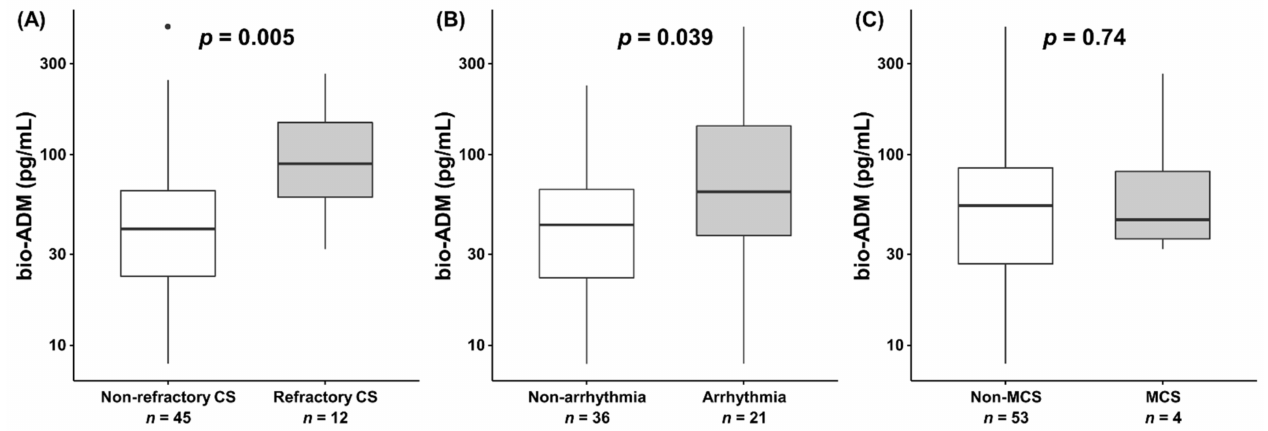
Figure 3. The value of bio-ADM at inclusion (boxplots) in ( A ) patients with or without refractory cardiogenic shock, ( B ) patients with or without arrhythmias (i.e., comprised ventricular tachycardia, ventricular fibrillation, atrial fibrillation), and ( C ) patients with or without mechanical circulatory support implementation. Dots indicate outliers. bio-ADM, bioactive adrenomedullin; CS, cardiogenic shock; MCS, mechanical circulatory